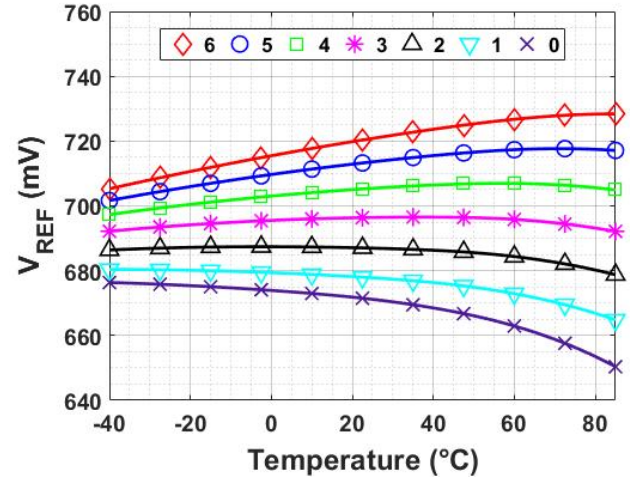
Figure 12. Trimming circuit. Table 4. Transistor dimensions of the trimming circuit.